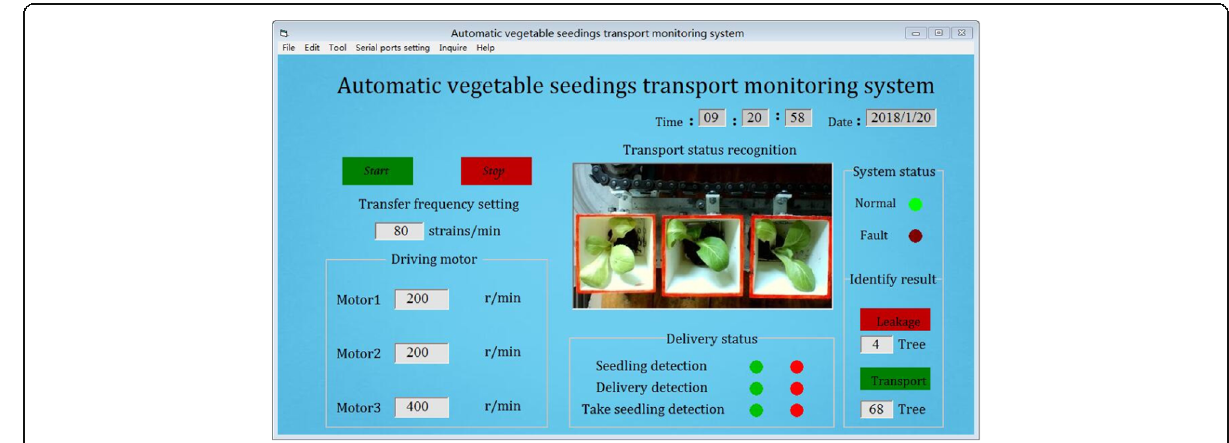
Fig. 8 Software interface of monitoring system